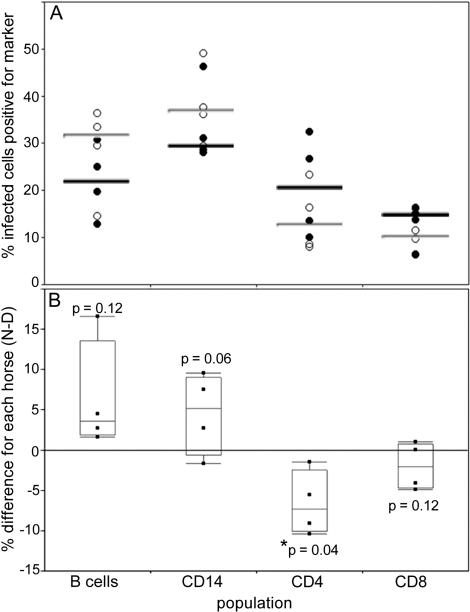
Equine PBMC Infection In Vitro(A) Each point represents the percentage of virus-infected cells that were positive for the respective equine cellular marker in an individual horse, as measured by FACS at 48 h postinfection. Cells were infected with either the neuropathogenic D752 revertant (•) or the non-neuropathogenic N752 mutant (○) virus; dark lines show median percentages for the revertant D752 group, and grey lines median percentages for the N752 mutant group.(B) Paired differences between the two viruses (percentage of infected cells expressing the respective cellular marker: N752 minus D752 for each individual horse) are plotted. The efficiency of PBMC infection ranged from 10% to 30%.